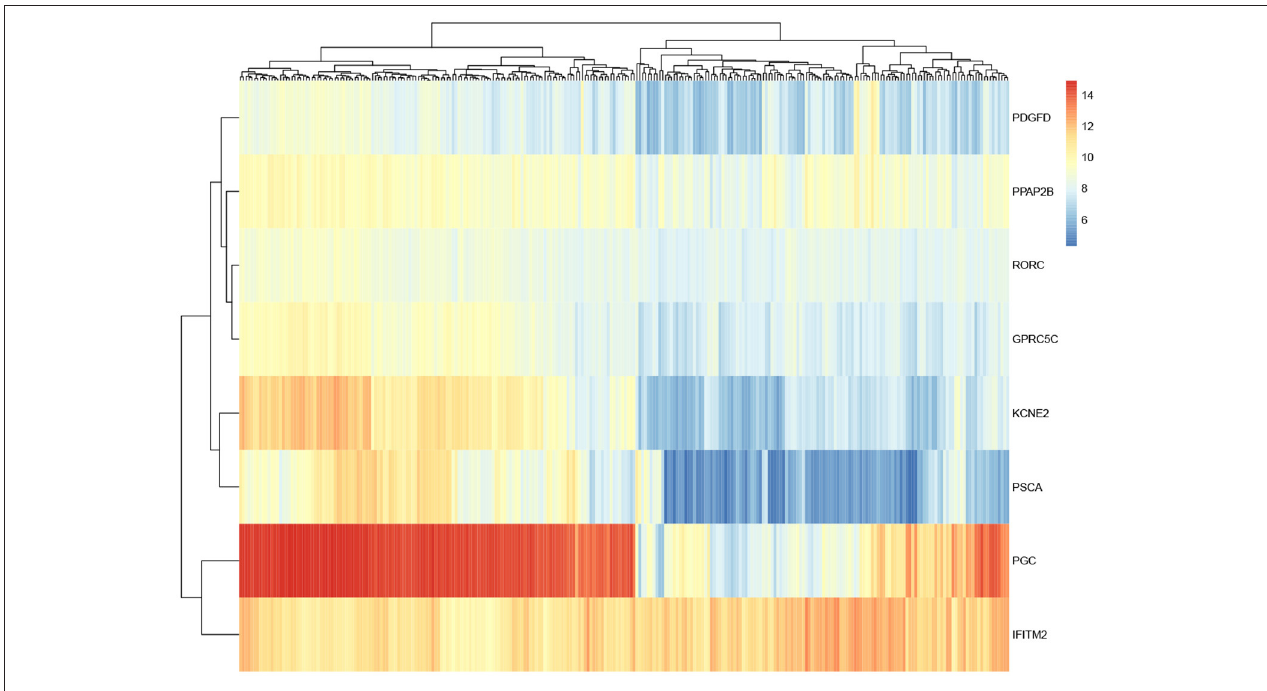
FIGURE 5 | Heatmap of eight overlapped genes.